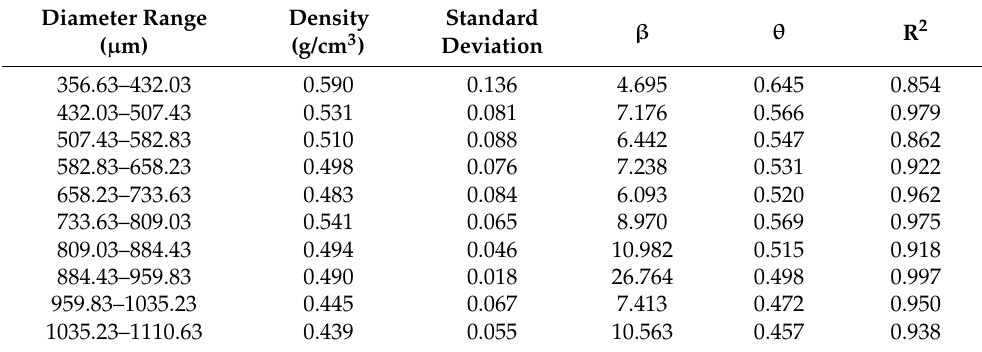
Figure 3. Frequency of the number of TVFs versus diameter range and their normal distribution curve. Table 1. Average geometric density calculated for the different diameter intervals .